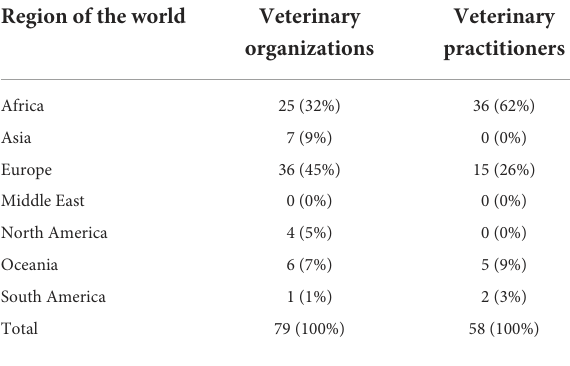
TABLE 1 Survey responses per region of the world and responding group. Region of the world